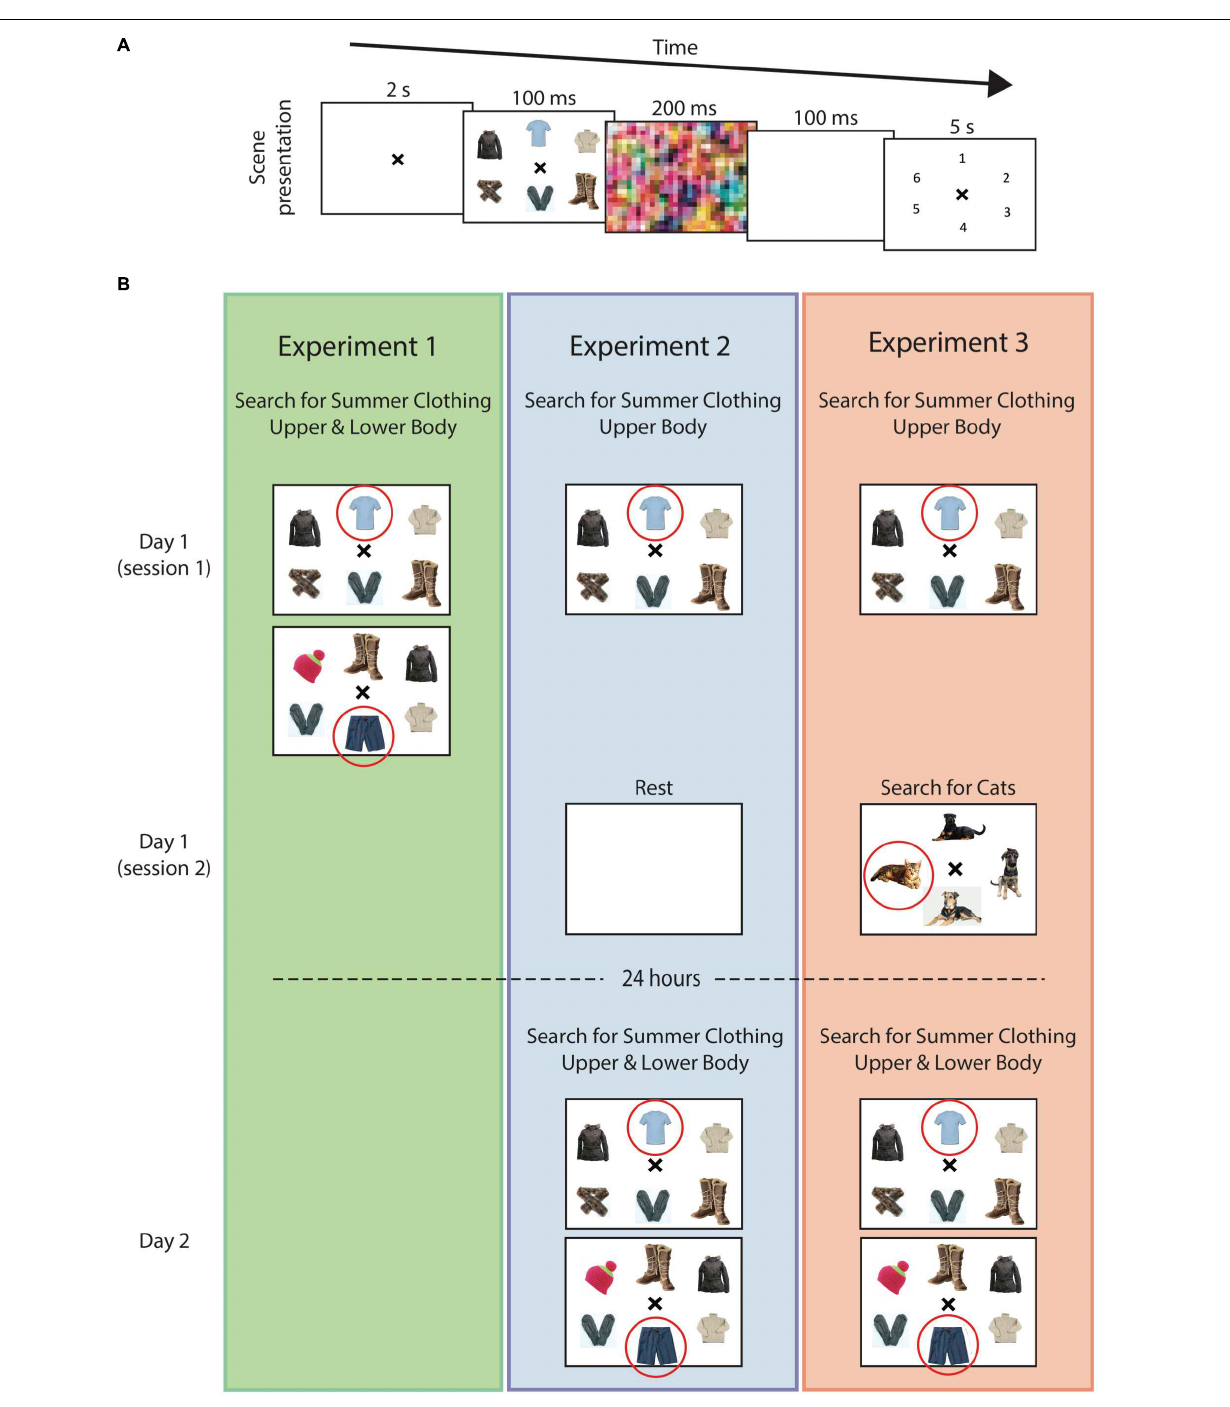
Frontiers in Psychology |